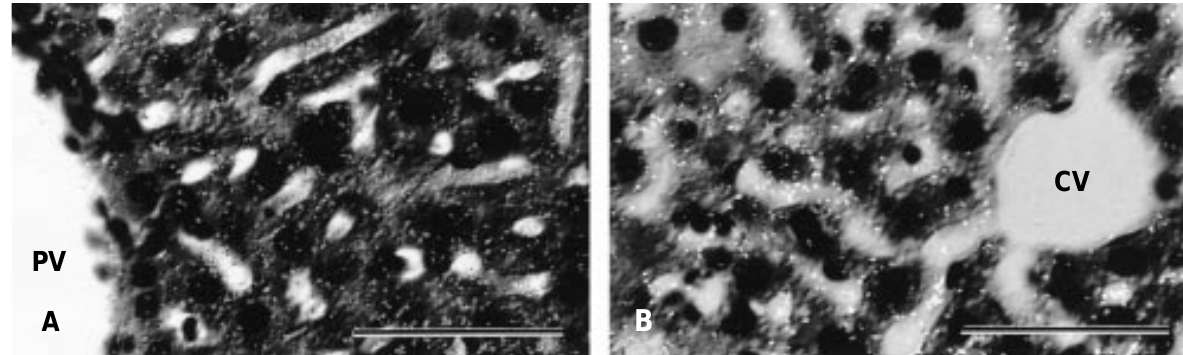
Figure 5 - Overlay images of differential interference contrast (DIC) and confocal LSM images of microradioautographs of mouse liver 3 min after intravenous injection of 125 I-glucagon. The number of silver grains in the periportal zone (A) is higher than that in the perivenous zone (B). PV, Portal vein; CV, central vein. Bar = 50